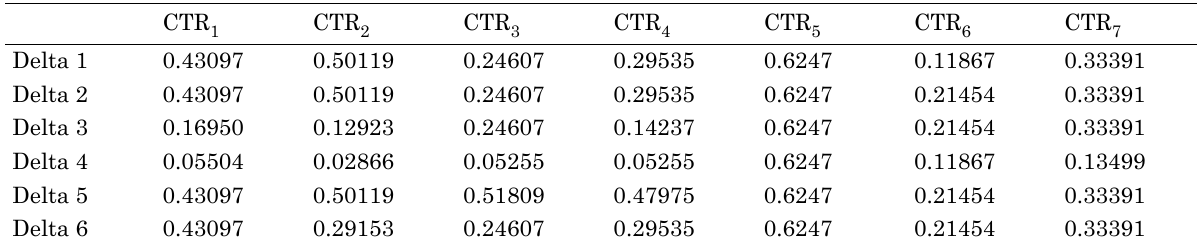
Table 5. Deltas’ partial